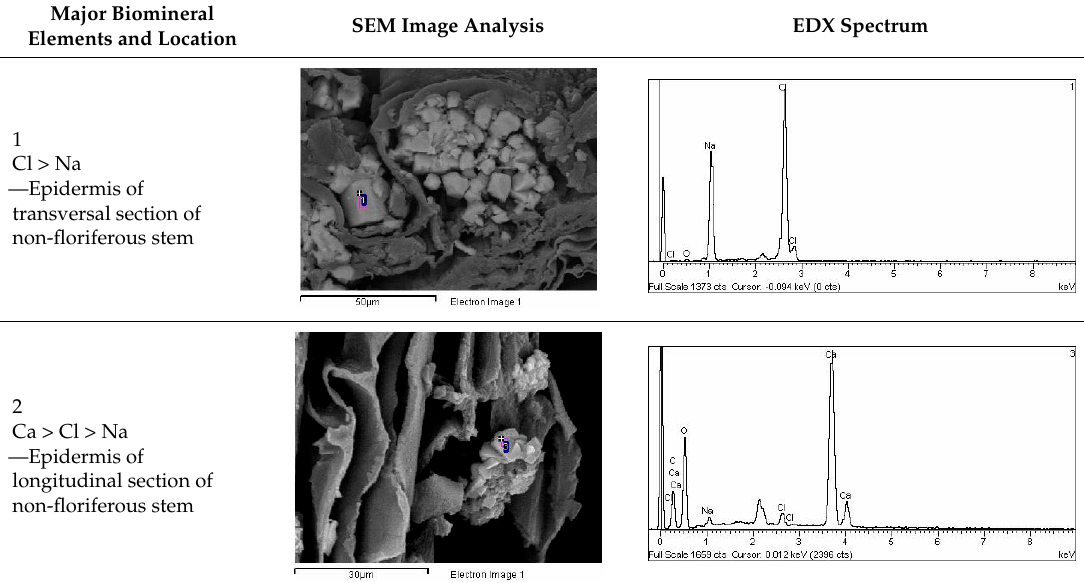
Table S1: Sarcocornia pruinosa ICP calculated for Na, Ca, Mg, K, Mn, Fe, Ni, Cu, Zn, As, Pb, Ba and Sr from plant concentrations of these elements. Data expressed in mg/kg.